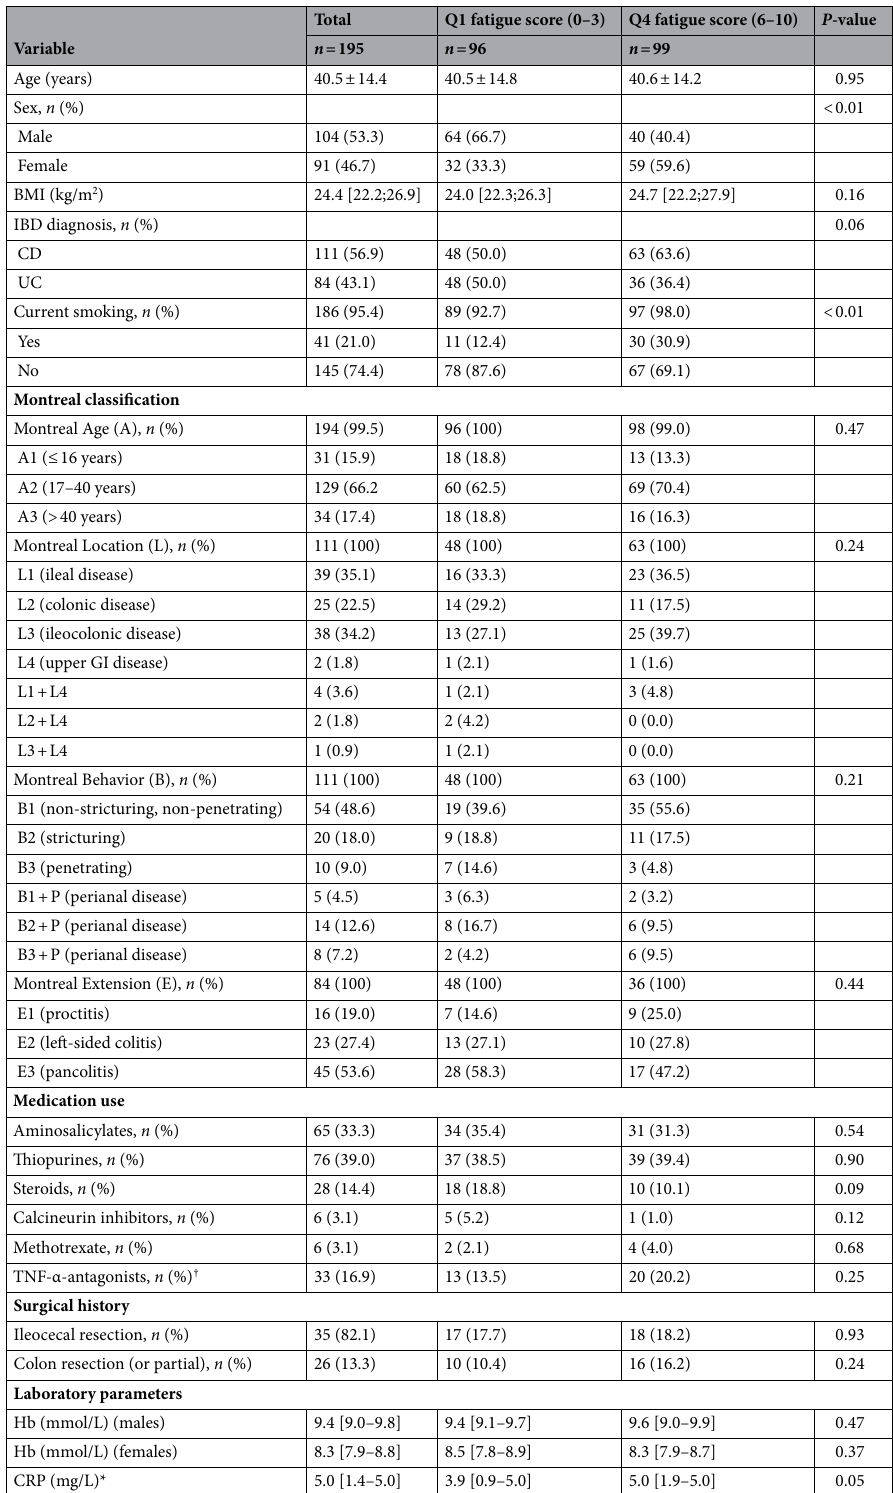
Table 1. Demographic and clinical characteristics of the study population compared between mildly fatigued (Q1) and severely (Q4) fatigued patients. Data are presented as proportions n with corresponding percentages (%) or as median [interquartile range, IQR] in case of continuous variables. P -values ≤ 0.05 were considered statistically significant. BMI body-mass index, CD Crohn’s disease, IBD inflammatory bowel disease, TNF-α tumor necrosis factor alpha, UC ulcerative colitis. *Numericized lower limits of detection (< 5 mg/L) were included in calculating median and IQR, but may falsely represent the (unknown) true biological value. All CRP values were < 5 mg/L, as this was one of the study’s inclusion criteria. † The use of TNF-α-antagonists included use of the following compounds: infliximab, adalimumab, golimumab and certolizumab